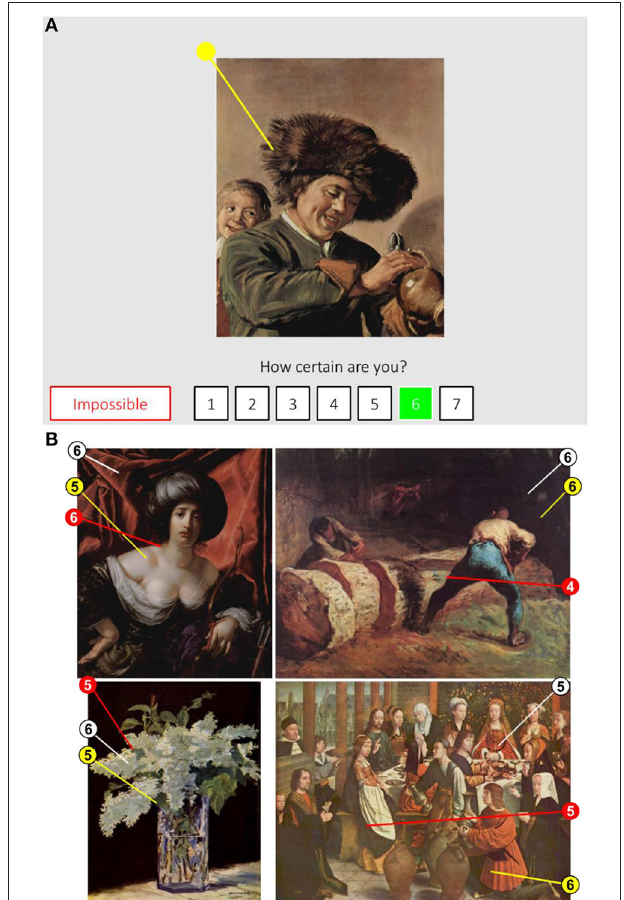
FIGURE 2 | (A) A screenshot of the experimental program. See text for details. (B) Examples estimates of the approximate direction of light in the paintings. Numbers depict participants’